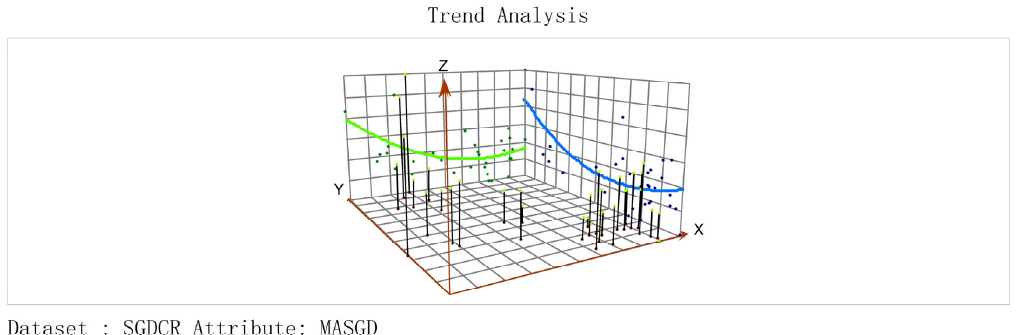
Figure 3. Shallow groundwater depth change rate (SGDCR) in Quzhou County in 2018 (multi-year average of shallow groundwater depth (MASGD)).